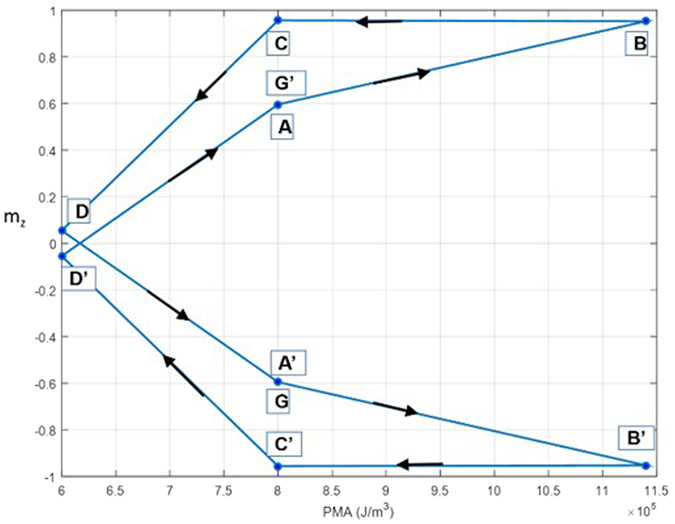
Normalized perpendicular magnetization (mz) vs. PMA.